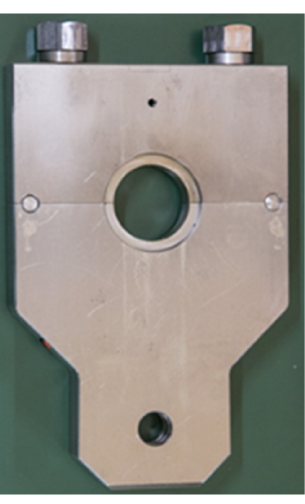
Figure 3. Highly rigid connecting rod.